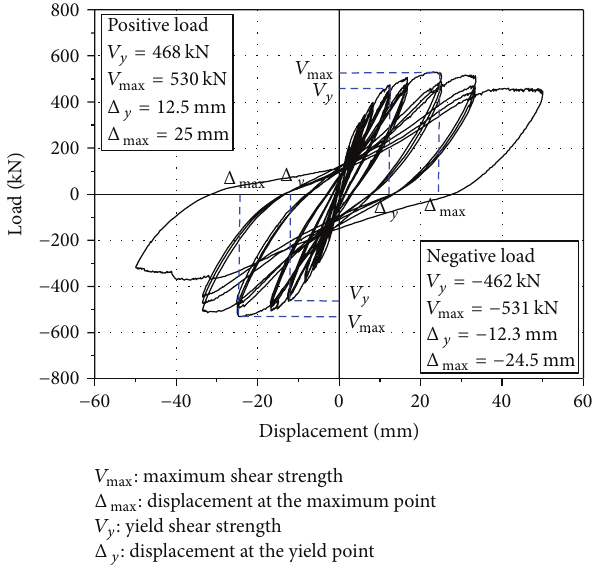
Figure 13: Lateral load-displacement curve for the CL-F specimen.